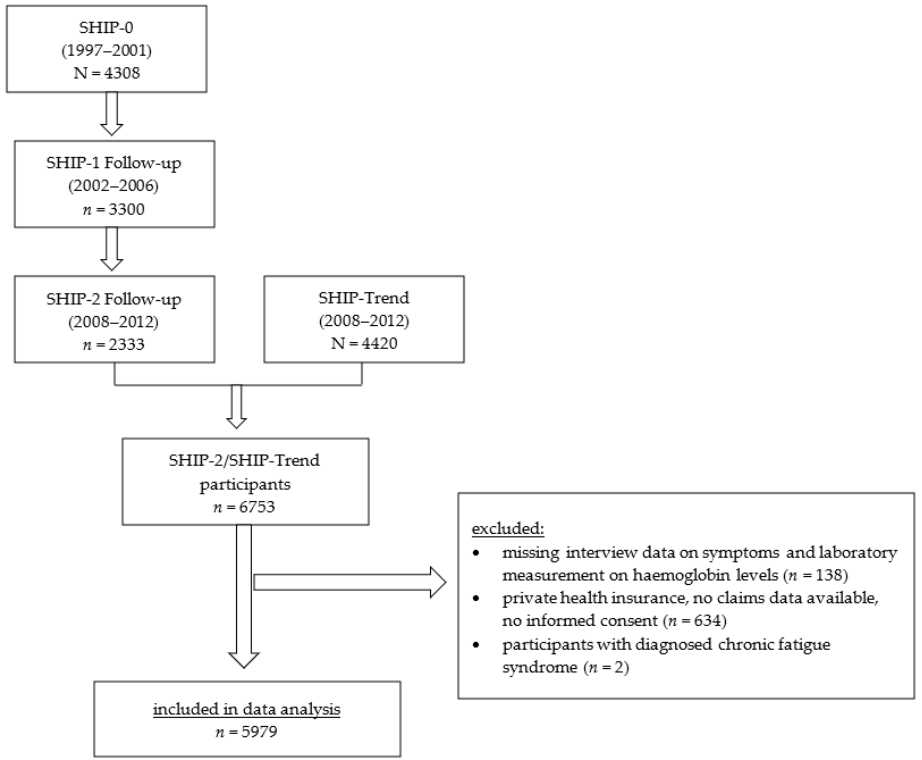
Figure 1. Flow chart of study population. SHIP: Study of Health in Pomerania.